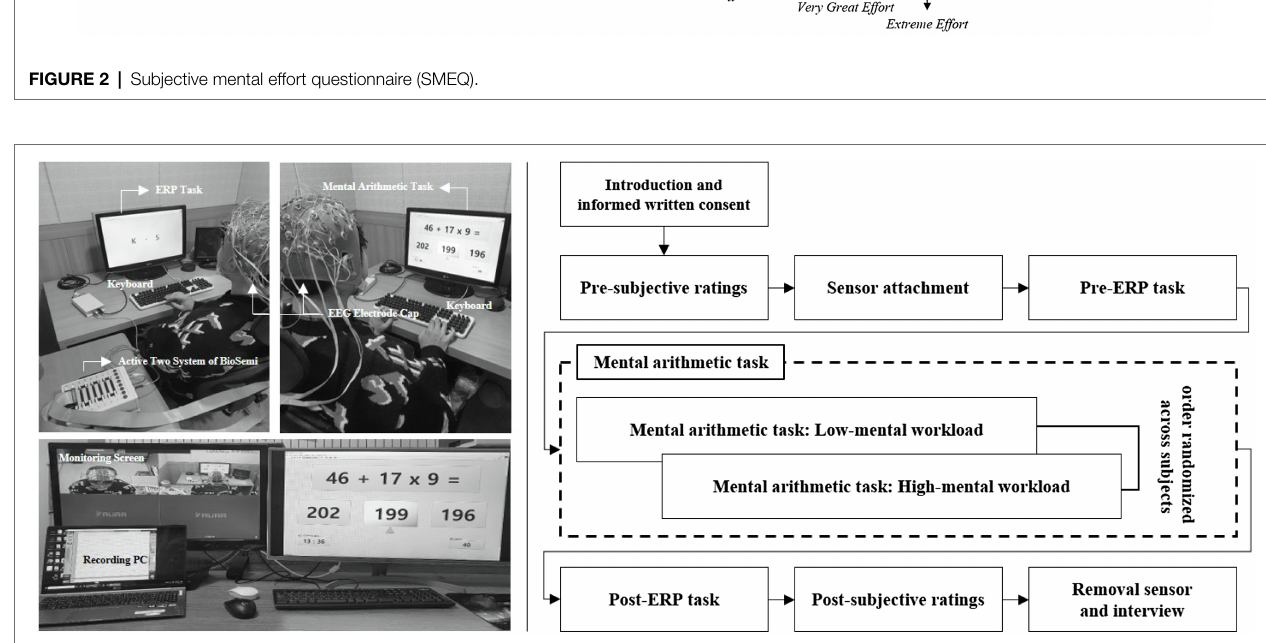
FIGURE 3 | Experimental environment (left) and procedure